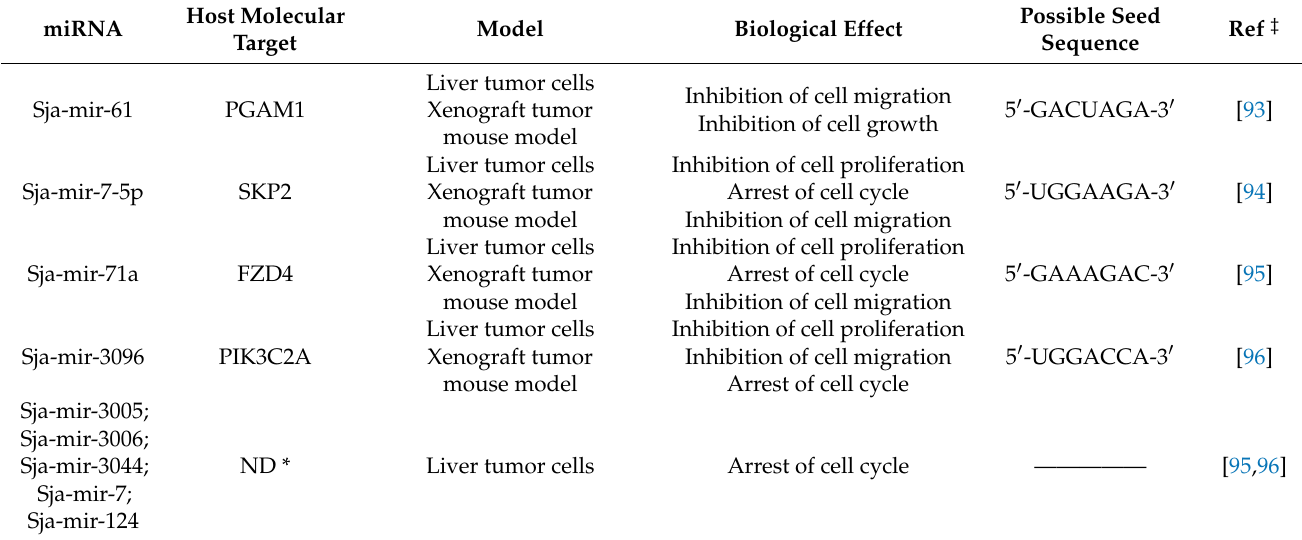
Table 1. miRNAs encoded by S. japonicum with antitumoral